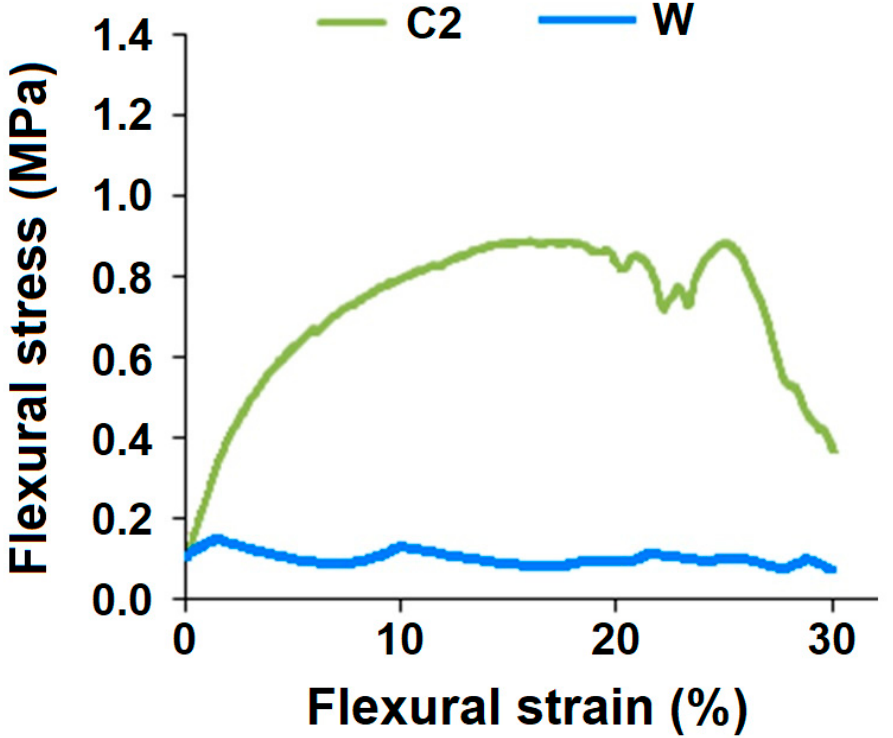
Figure 11. Flexural behavior of RC fiber-based hollow composite (C2) and cardboard material (W).